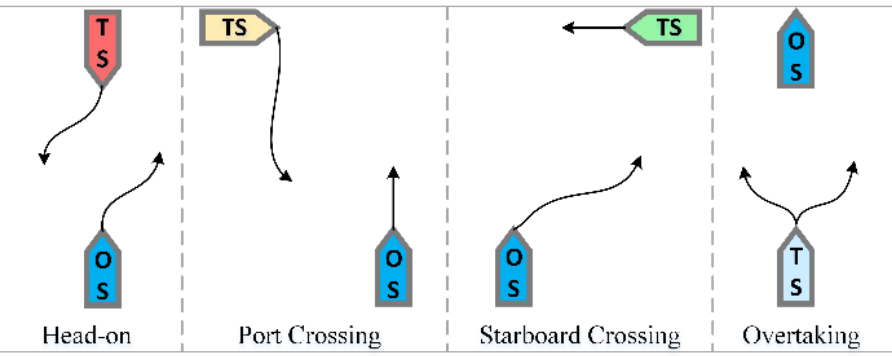
Figure 5. Encounter situations defined by COLREGs.